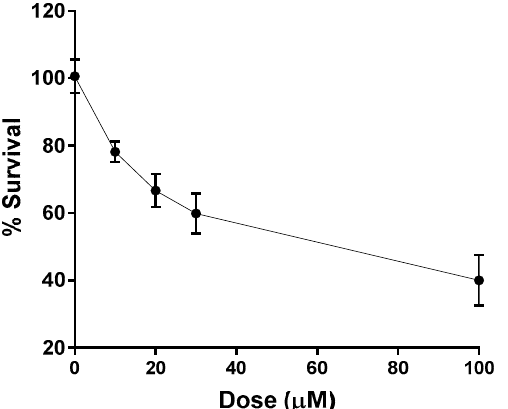
Figure 4. Cytotoxicity of compound 5a against MCF-7 cell line (hormone-sensitive breast cancer cells). Data are expressed as mean ± SEM ( n = 3). Nonlinear regression and IC 50 value determination were performed using GraphPad Prism 6.